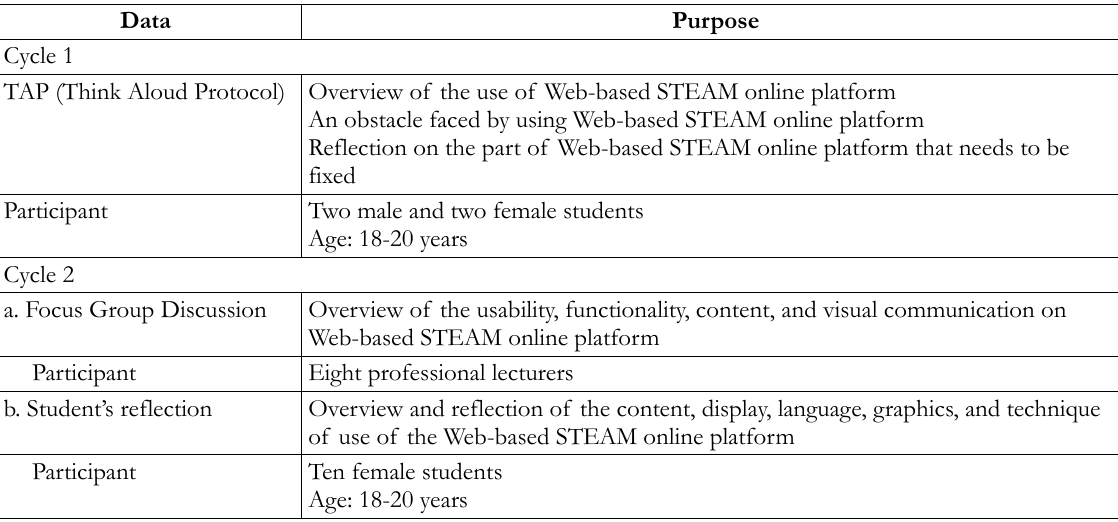
Table 3. Development of Web-based STEAM online platform in three Stages of Testing